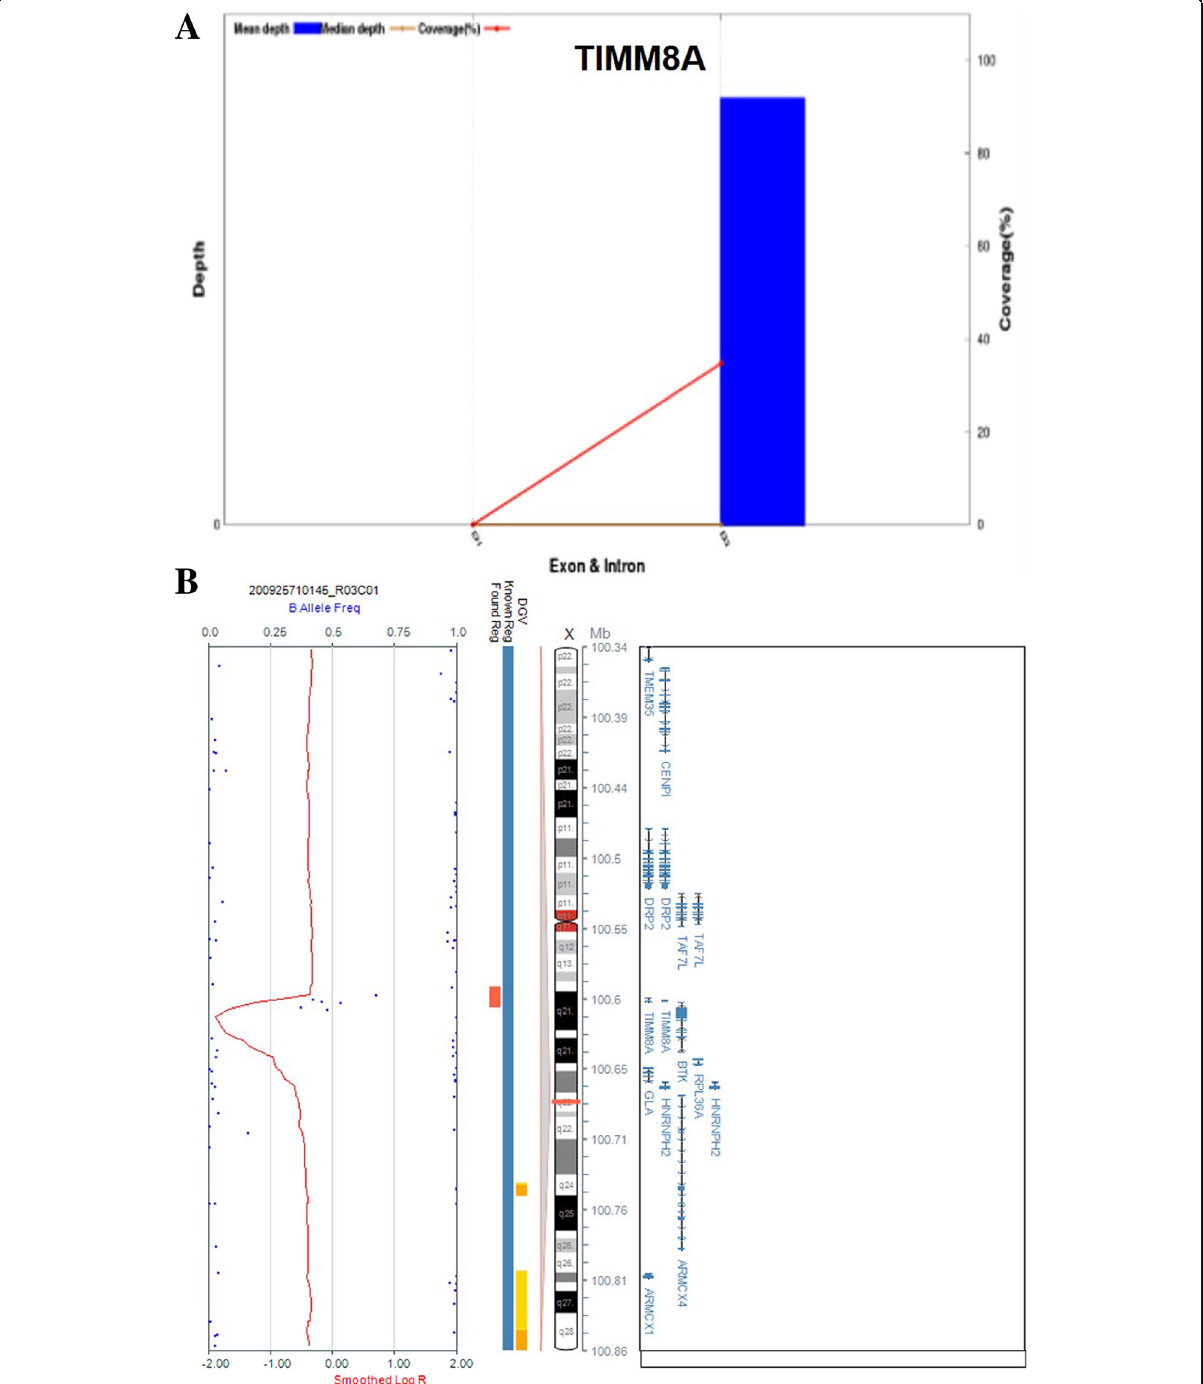
Fig. 5 Copy number variation including TIMM8A of Family 3. a NGS result showing the deletion in the TIMM8A gene. b Molecular cell karyotype of Xq22.1(100,593,213-100,609,547) × 0 of the proband from Family